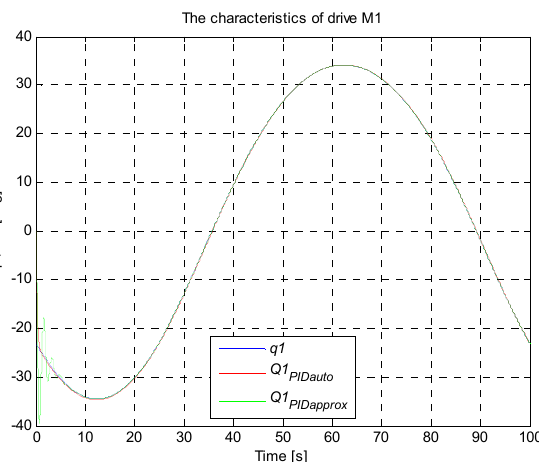
Figure 18. The courses of set and controlled configurational variables for the drive of the first arm.